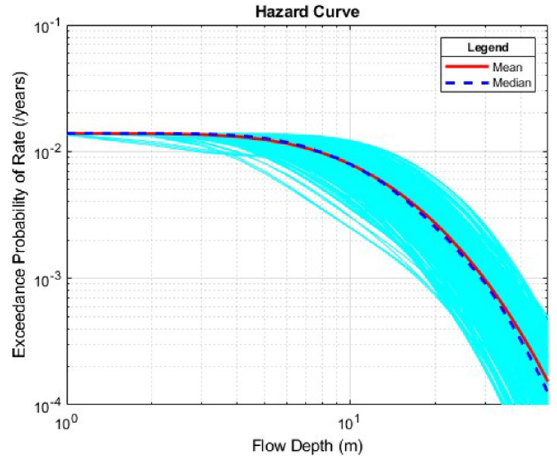
Fig. 9 Tsunami hazard curve at each observation point (blue), including mean and median graphs for the study area